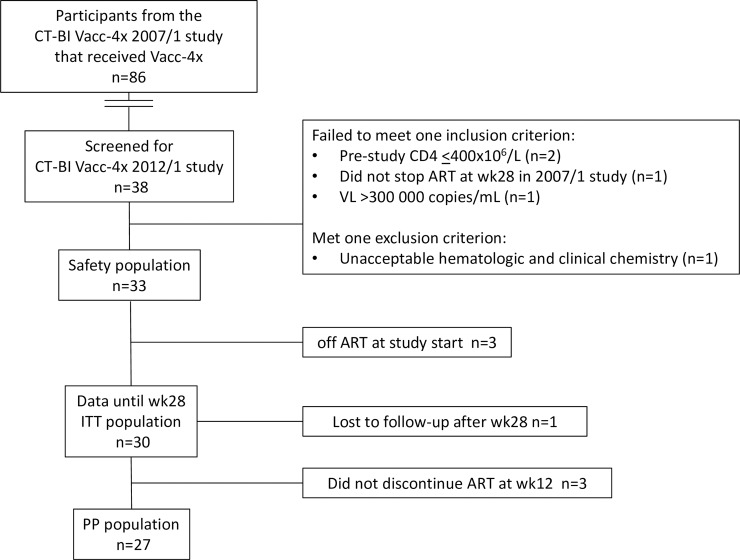
CONSORT diagram for the 2012/1 clinical study.ITT: Intention to treat population. PP: per protocol. One participant was lost to follow-up after completing the week 28 visit, but was included in outcomes analysis in the ITT population. ART: antiretroviral therapy.